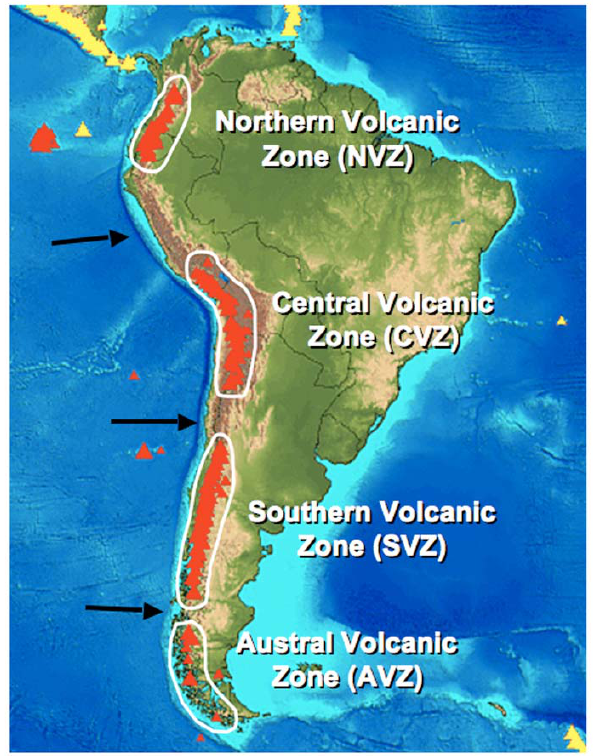
Fig. 3. The Andean Volcanic Arc is not continuous and consists of four segments, which are separated by volcanically inactive gaps hundreds of kilometers in length (see text). The black arrows mark regions where the subduction angle is relatively flat.